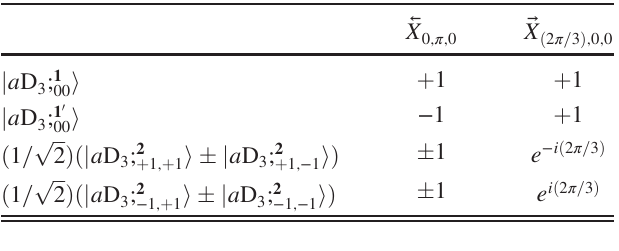
TABLE II. Dihedral codes. Check operators for the D 3 ⊂ D 6 codes and their corresponding eigenvalues and eigenstates within the 12-dimensional subspace j R i for R ∈ D 6 , where a ∈ f I; R g ð π =N Þ 00